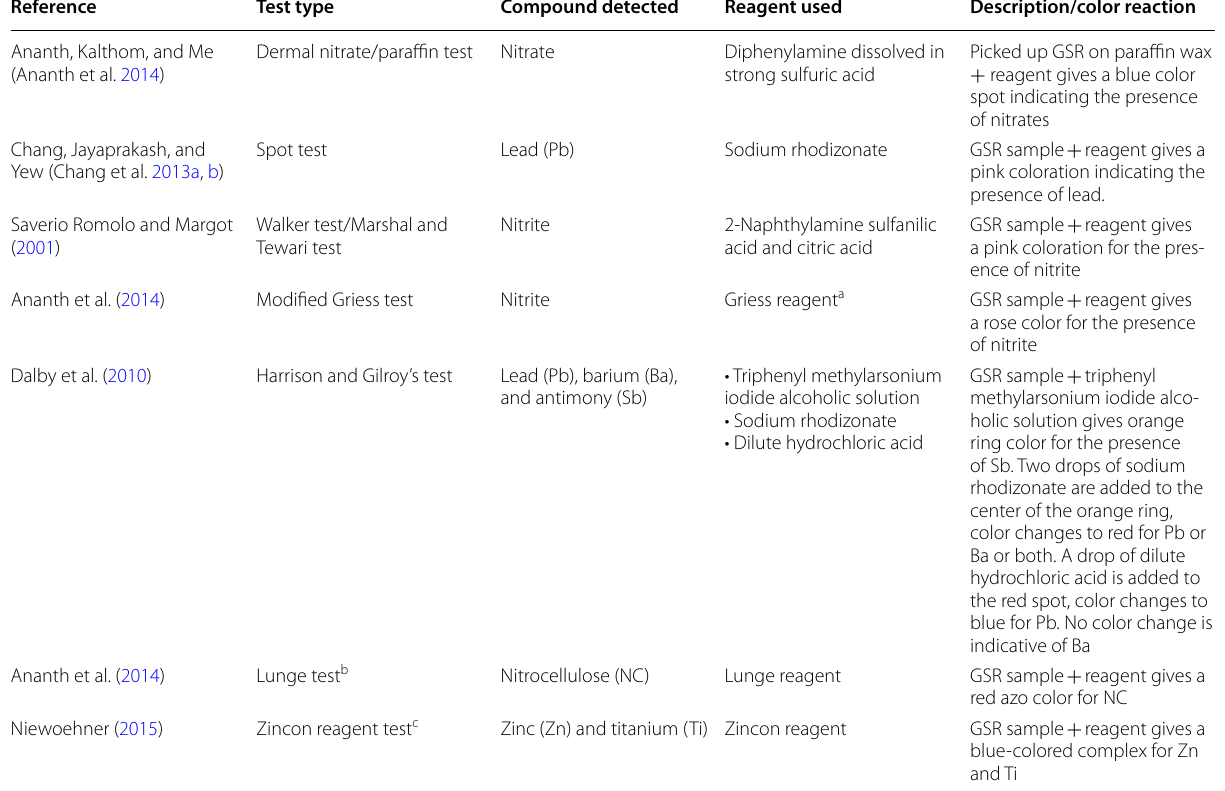
Table 1 Chemographic method for GSR